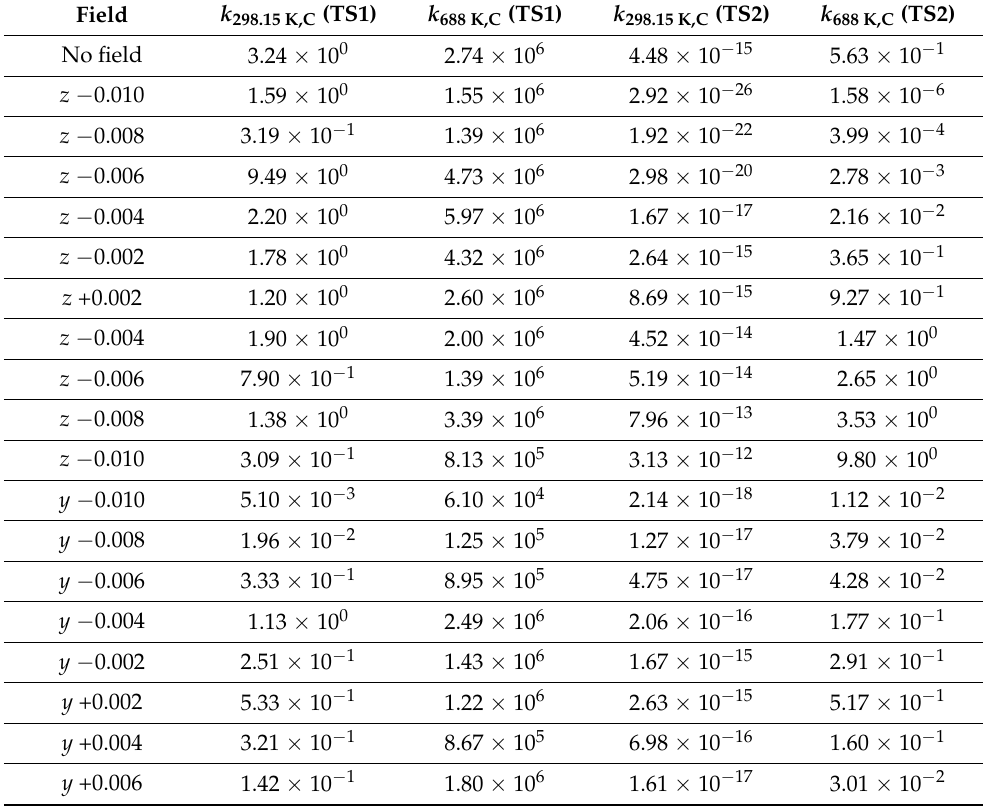
Table 1. Corrected reaction rate constants ( k 298.15 K,C and k 688 K,C , s − 1 ) in the absence and presence of fields of varying strengths and directions for the intermolecular hydrogen exchange path (TS1) and 1,3-intramolecular hydrogen transference path (TS2) at the MP2/6-311++G(2d,p)